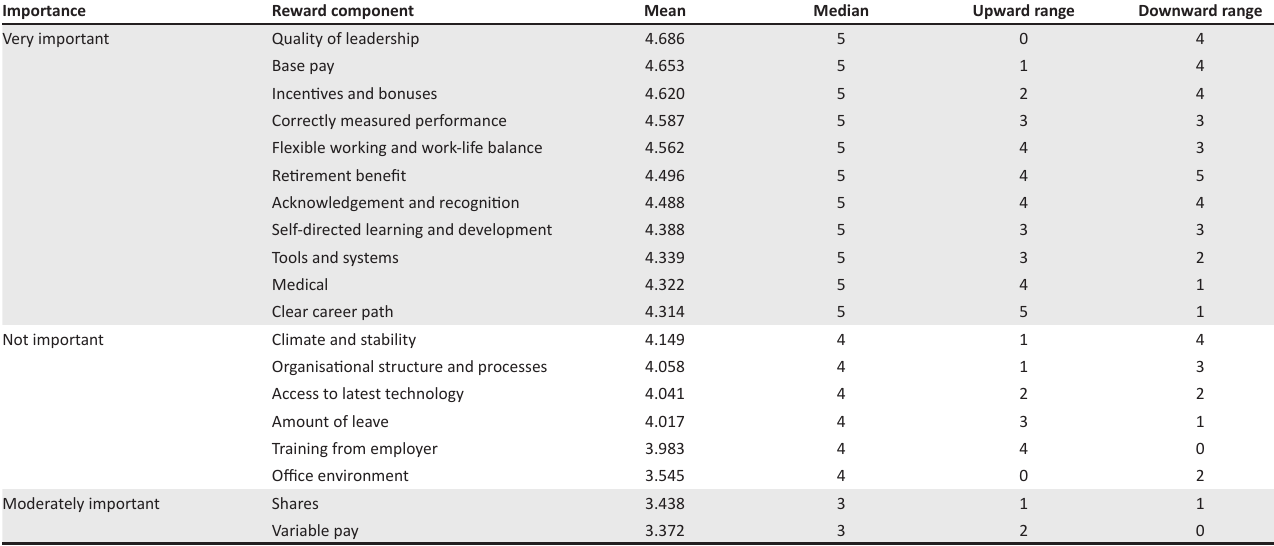
TABLE 3: Summary of overall reward preferences sorted by median and mean. Importance